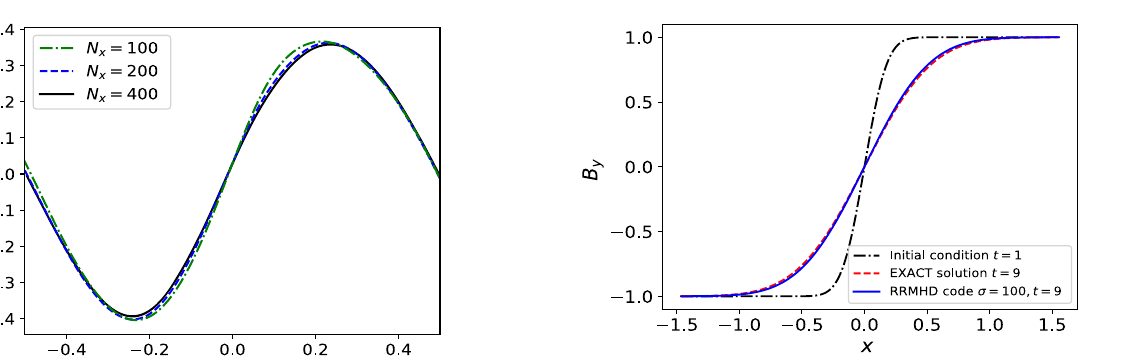
Fig. 4 Themagneticfieldcomponent B z at t = 2 . 2and y = 0isshown in the two-dimensional propagation of large amplitude circularly polar- izedAlf´venwaves.Thegreenlongdashed-dotted,reddashed,andblack solid lines represent results with σ = 10 2 and N x = { 100 , 200 , 400 } , respectively